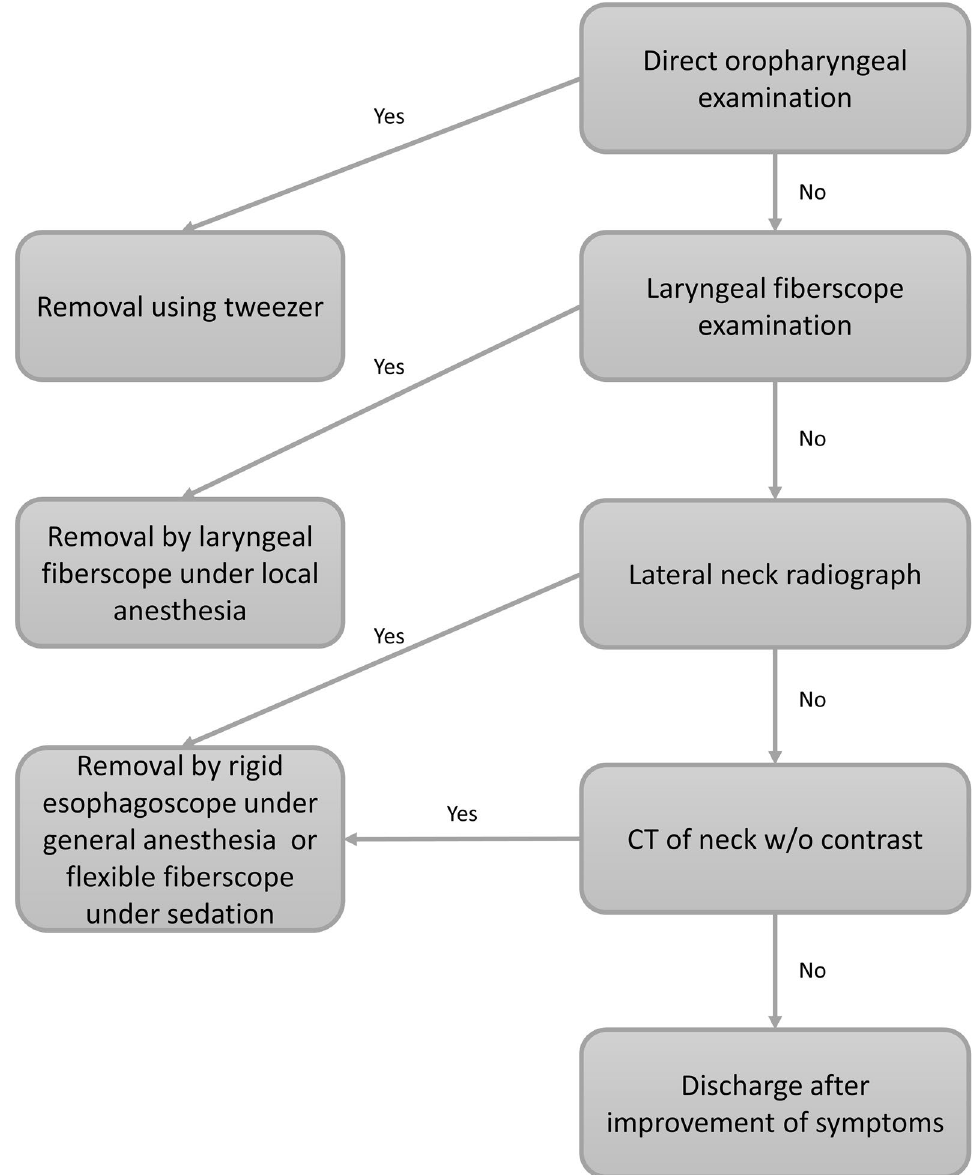
Fig. 1 Clinical workflow for suspected animal bone impaction. Patients presenting with animal bone impaction will receive direct oral examination followed by laryngeal fiberscope if the oral examination is not revealing. Any bones found will be directly removed during the examination. If no foreign body is detected, then a lateral neck radiograph will be performed. If the foreign body is still not identified, then a CT without contrast medium administration from the tongue base to the stomach will be performed. If the foreign body is detected in the esophagus, either by